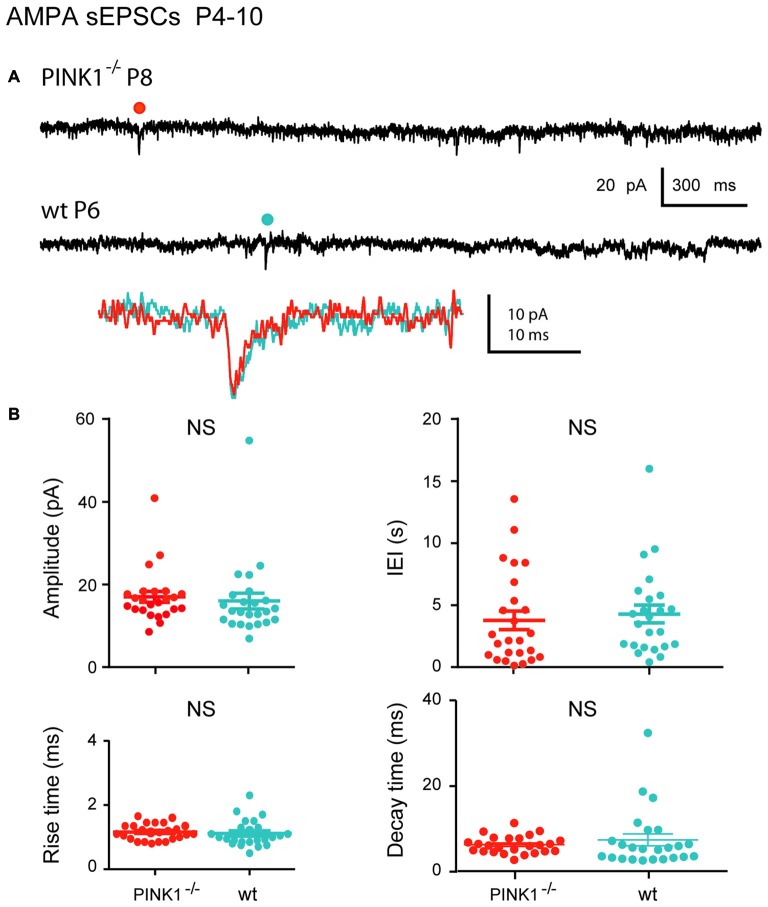
α-amino-3-hydroxy-5-methyl-4-isoxazolepropionic acid (AMPA) spontaneous excitatory postsynaptic currents (sEPSCs) in immature (P4–10) pink1−/− SNc DA neurons and comparison with age-matched wt SNc DA neurons. (A) Voltage-clamp recordings of AMPA sEPSCs from a P8 pink1−/− (red) and a P6 wt (blue) SNc DA neurons in the continuous presence of gabazine (5 μM) and APV (40 μM) at VH = −60 mV. AMPA events indicated by a dot are enlarged and superimposed in the inset. (B) Quantification and statistical comparison of the amplitudes and inter-event intervals (IEIs) and of the rise and decay times of P4–10 pink1−/− (n = 25) and wt (n = 24) AMPA sEPSCs, as indicated.